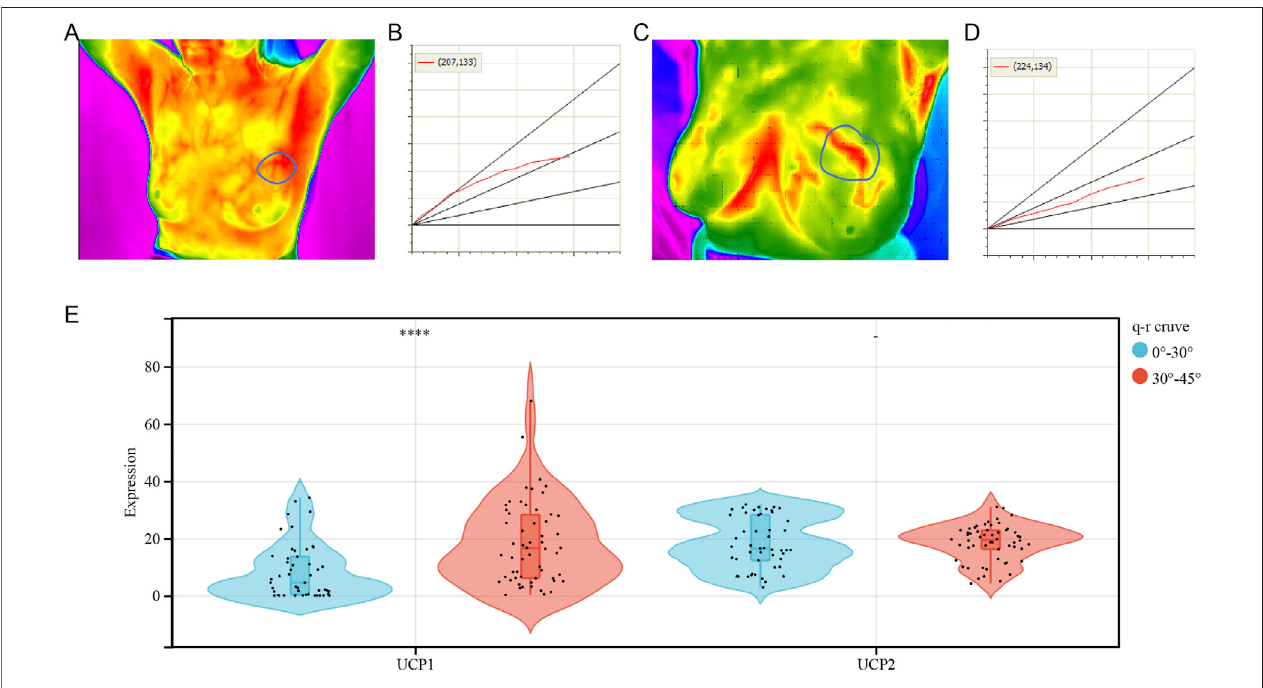
FIGURE 7 | Correlation analysis between UCPs and tumor thermogenesis. (A,B) Representative (A) heat map and (B) q-r curve for breast cancer patients with a high rate of thermogenesis. (C,D) Representative (C) heat map and (D) q-r curve for breast cancer patients with a low rate of thermogenesis. (E) UCP1 and UCP2 expression for varying q-r curve status. The statistical difference was compared through the student t-test. * p < 0.05; ** p < 0.01; *** p < 0.001; **** p < 0.0001.